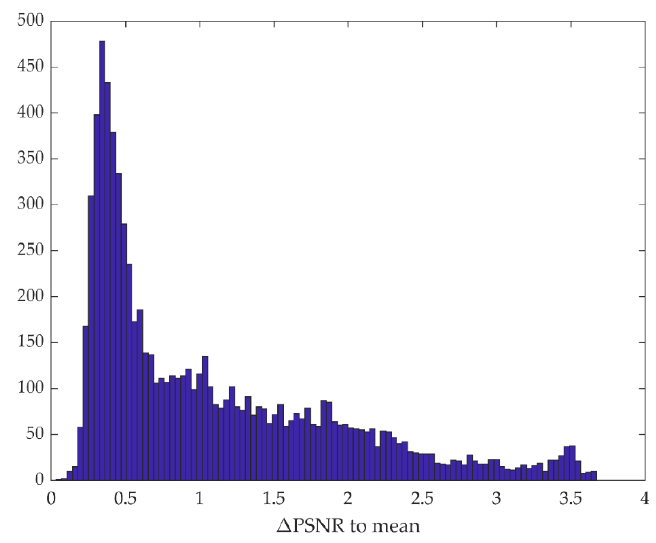
Figure 8. Histogram of ∆ PSNR for test images.